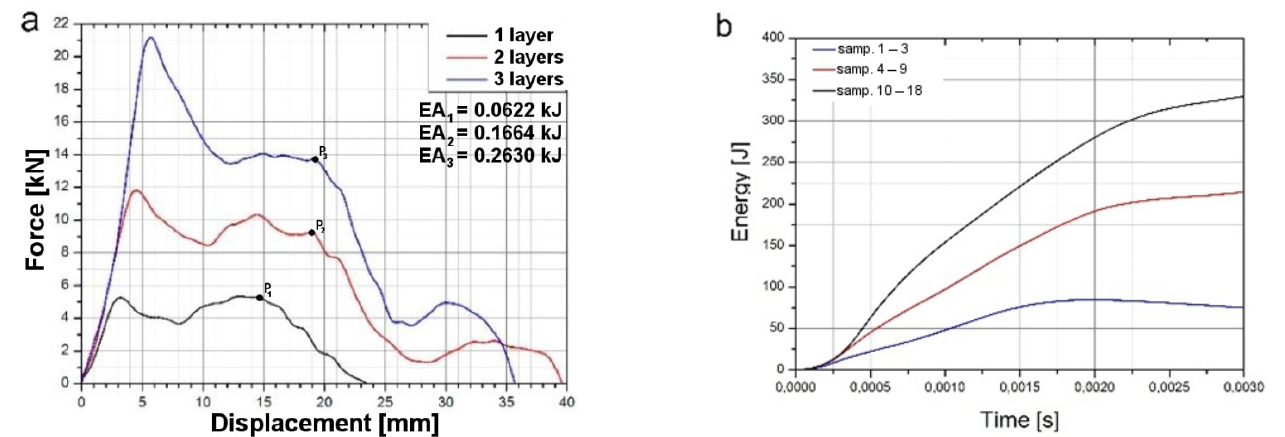
Figure 11. Comparison of averages: force–displacement ( a ) and energy during puncture ( b ) graphs.